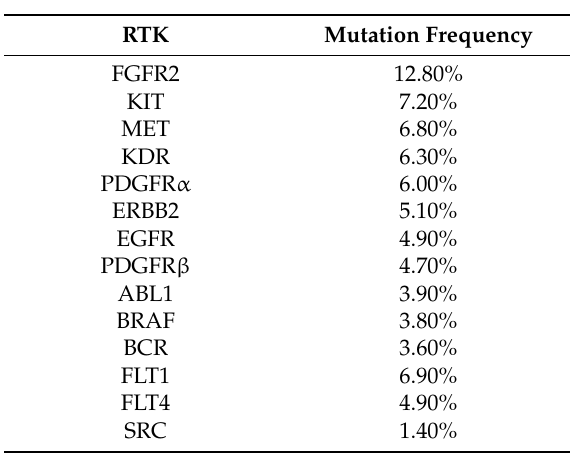
Table 1. Mutation frequency of the most relevant RTKs in EC. Data obtained from cbioportal